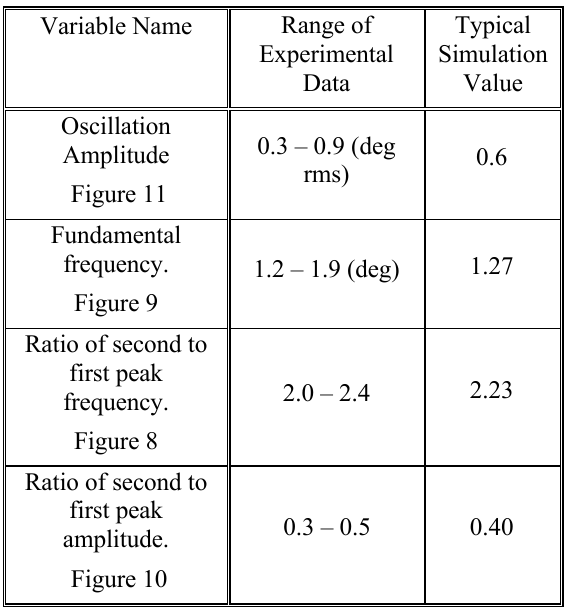
Table 1: Model verses Experimental